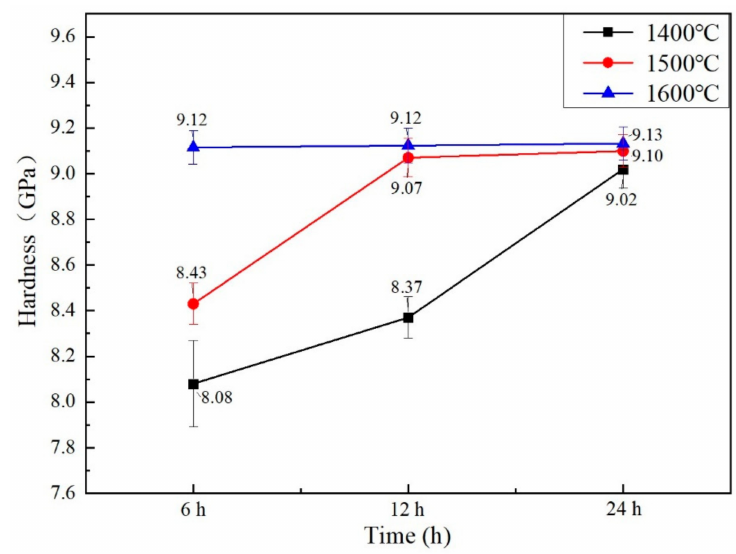
Figure 6. The sintered Gd 2 O 3 bulks’ hardnesses.